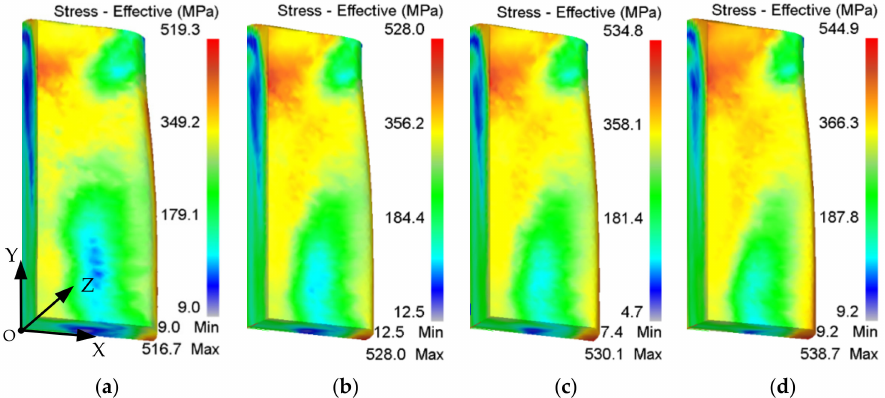
Figure 10. Simulation results of effective stress under V = 25 mm/s and water cooling. ( a ) T = 950 ◦ C,